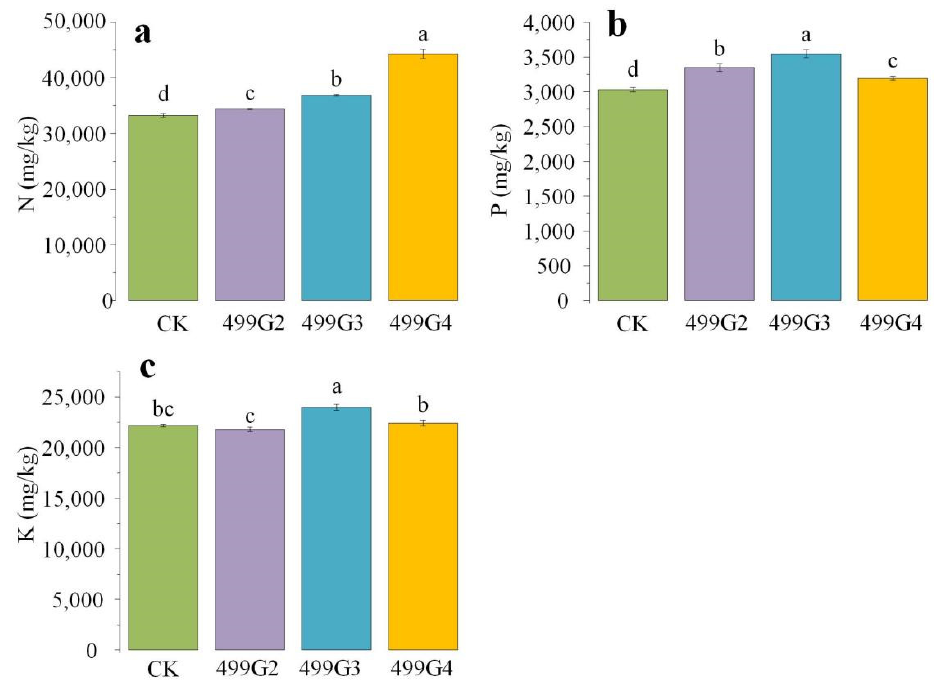
Figure 4. Effects of inoculum application on total nitrogen ( a ), total phosphorus ( b ) and total potassium ( c ) contents in cultivated rice. Error bars represent standard errors ( n = 3). Different lowercase letters show statistically significant difference ( p value < 0.05).